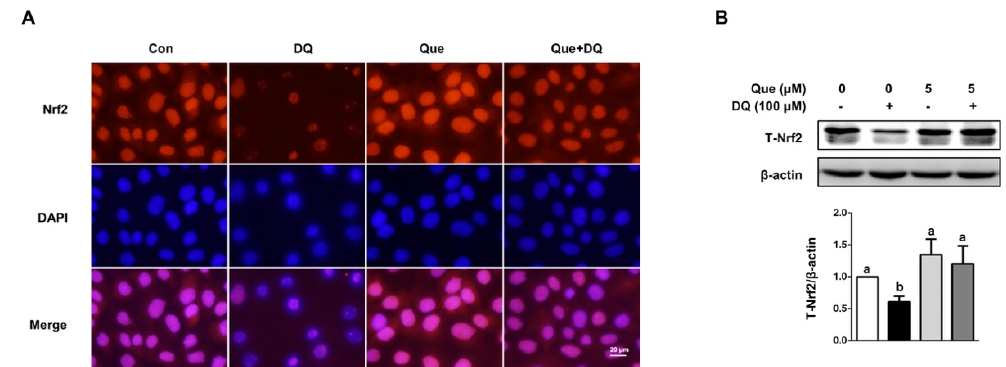
Figure 4. Quercetin attenuated diquat-induced the expression and distribution of Nrf2 in IPEC-1 cells. IPEC-1 cells were treated as described in Figure 2. ( A ) The distribution of Nrf2 in nucleus was determined by immunofluorescence staining (magnification ×400). ( B ) The abundance of Nrf2 in whole-cell proteins was determined and quantified by Western blot assay. β -actin was used as the loading control. Representative experimental results were repeated in three independent experiments and values are means ± SEMs, n = 3. Means without a common letter are considered as a significant difference, p < 0.05.